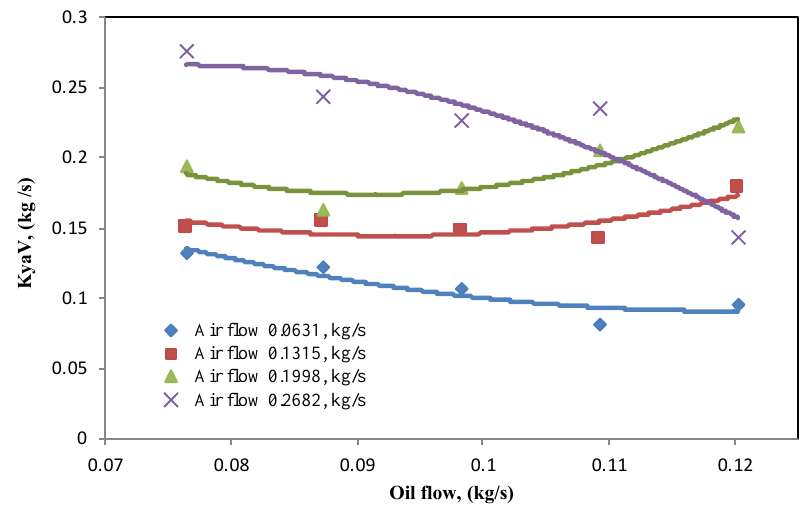
Figure 18. Average HD mass transfer coefficient at different air and oil flow rates.